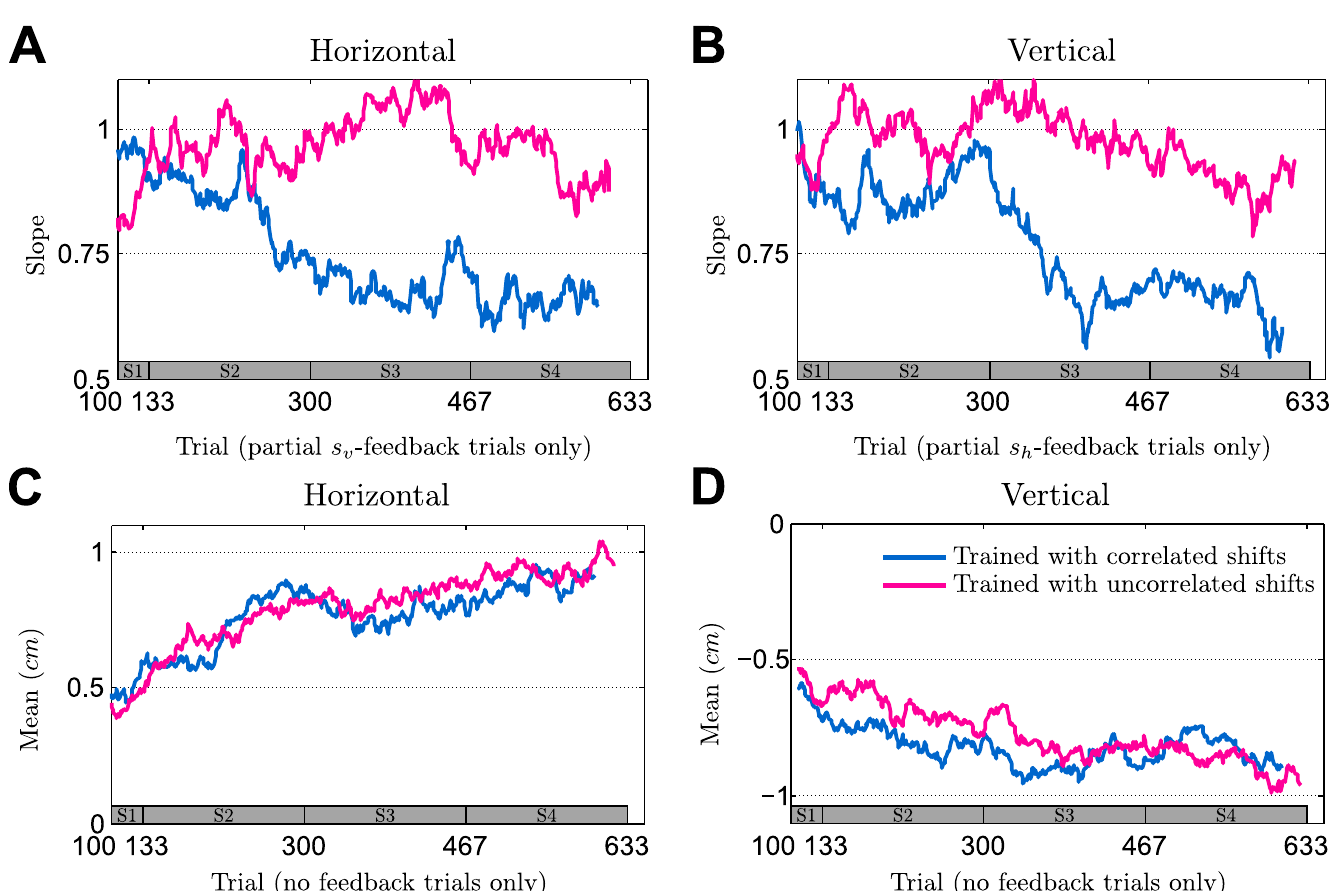
Fig 10. Simulation results. The plots show the simulation results as medians over six different simulation runs. Blue lines show the medians over six runs where the model was trained with correlated full feedback trials. Pink lines show the medians over six run where the model was trained with uncorrelated full feedback trials. A Median for evolution of horizontal slope in partial s v -feedback trials — compare Fig 9A which shows the participants ’ results. B Median for evolution of vertical slope in partial s h -feedback trials — compare Fig 9B which shows the participants ’ results. C Median for evolution of horizontal mean- response in no feedback trials — compare Fig 7 and Supplementary S2E Fig which shows the participants ’ results. D Median for evolution of vertical mean- response in no feedback trials — compare Fig 7 and Supplementary S2F Fig which shows the participants ’ results. The parameters of the model (strength of the initial belief over mean-shift and covariance matrix) were chosen in order to minimize the sum-of-squared-differences between the correlated simulation median and the median obtained from participants from the correlated group. The uncorrelated simulation run used the same set of parameters.